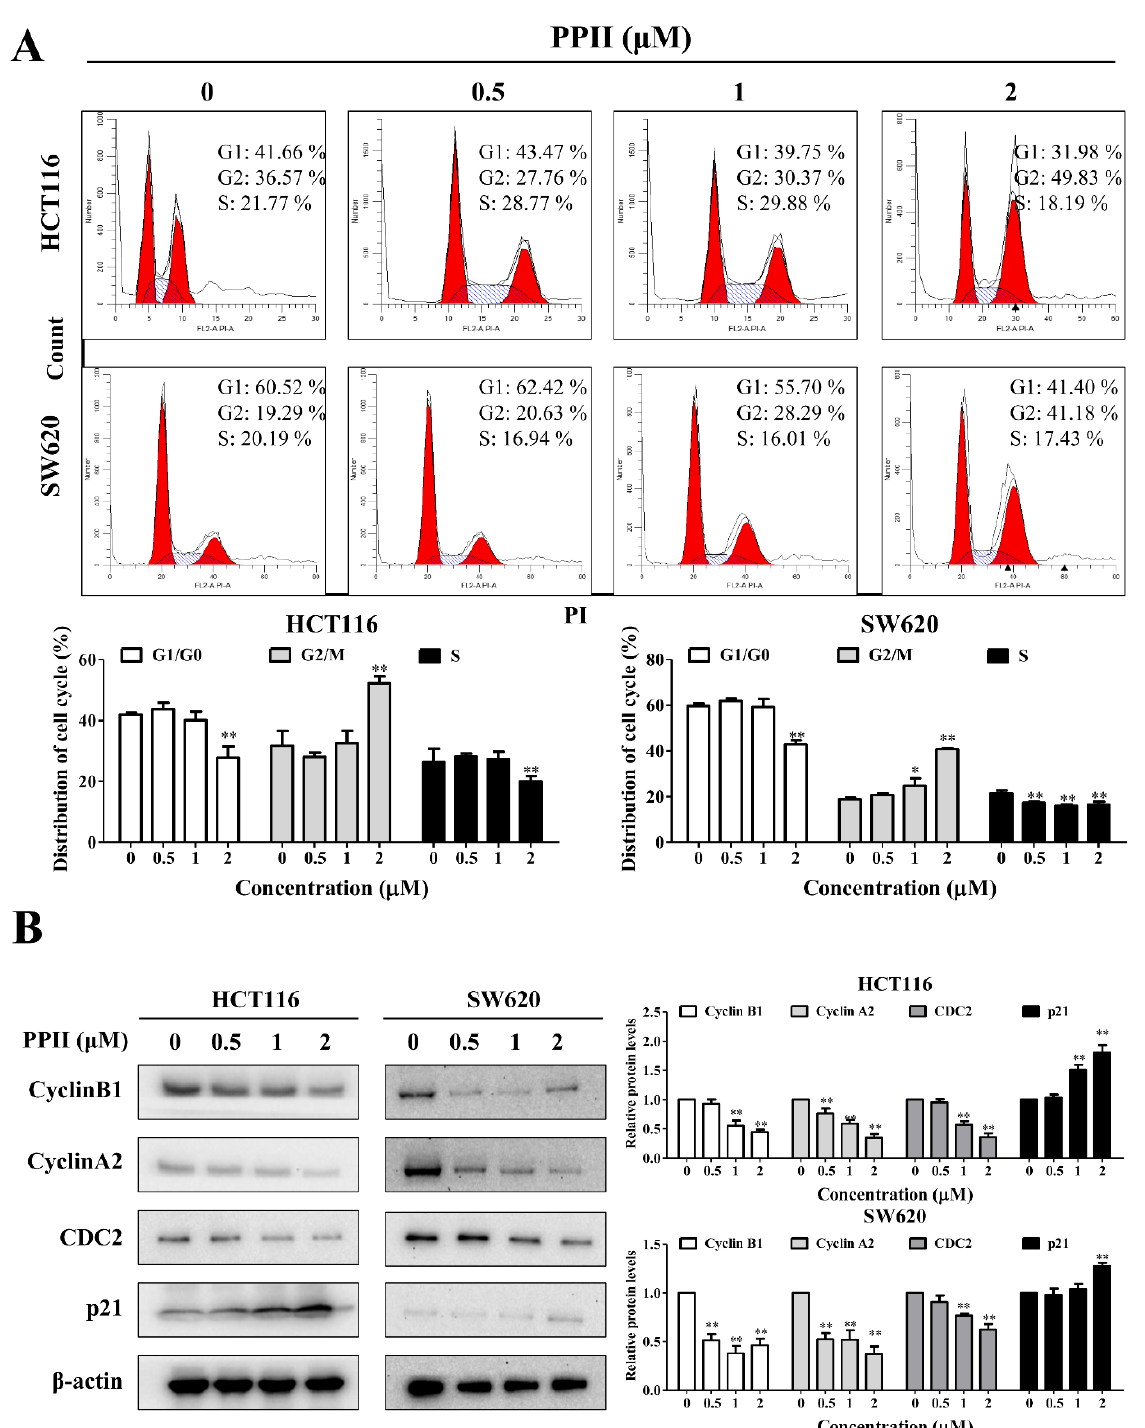
Figure 2. PPII induces G2/M-phase cell cycle arrest in CRC cells. CRC cells were treated with various concentrations of PPII for 24 h. ( A ) PPII-induced G2/M-phase cell cycle arrest in CRC cells. The cell cycle distributions were examined with flow cytometry. ( B ) Effects on cell cycle arrest-related protein levels. The protein levels of cyclin B1, cyclin A2, CDC2, and p21 were determined using immunoblotting. β -actin was included as a loading control. The representative results (left panels) and relative protein levels (right panels) are shown. The data shown in the bar charts are the means ± SD of three independent experiments. * p < 0.05 and ** p < 0.01 vs. vehicle control.